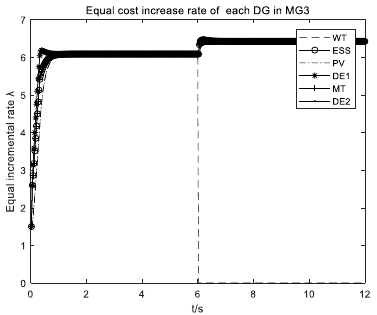
Figure 13. Equal cost increase rate of each DG .